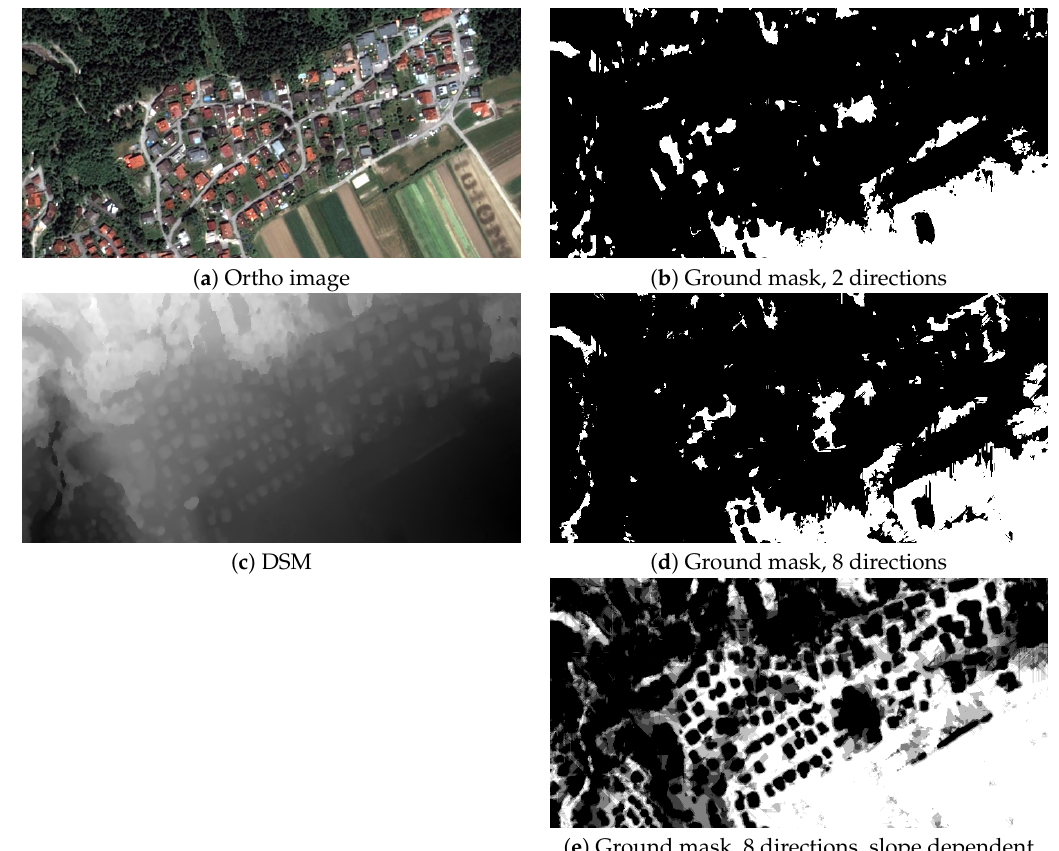
Figure 26. Subset of ( a ) true-ortho image, ( c ) input DSM and ( b , d , e ) together with ground masks using different methods.